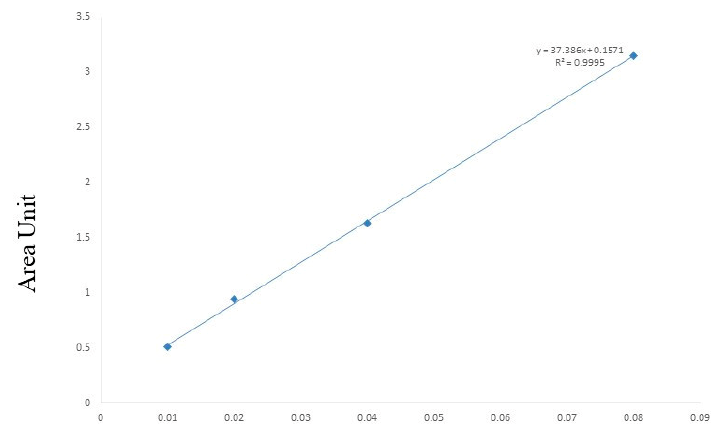
Figure 7. Calibration curve of andrographolide for quantitative analysis.